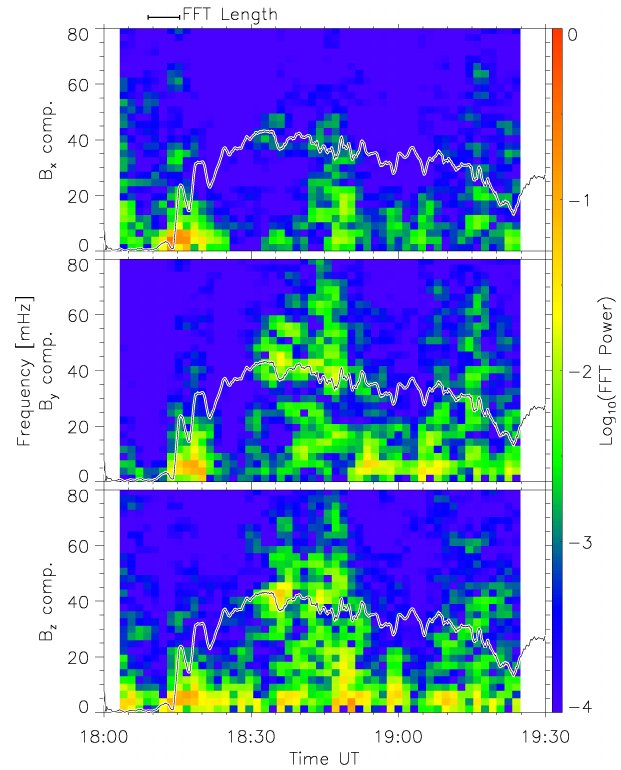
Fig. 2. Dynamic spectra of the Geotail magnetic field data. The superimposed black line gives the frequency predicted by Eq.